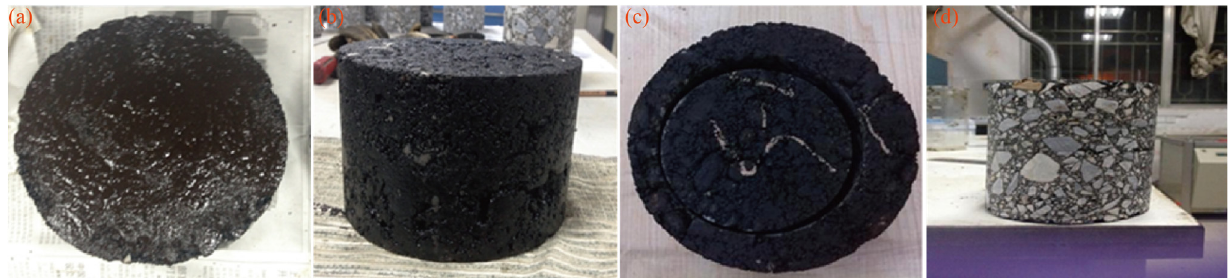
Figure 6. Schematic diagram of the specimen (actual thickness of bond layer is very thin, which can be considered as no thickness).